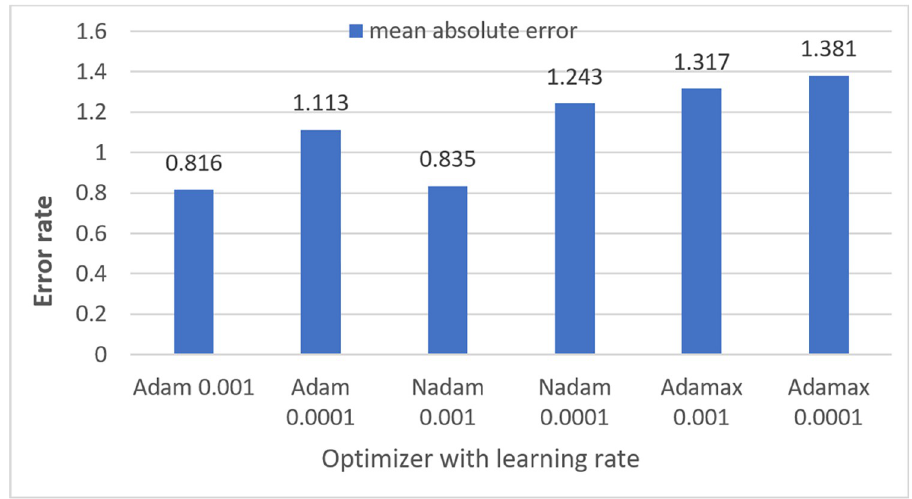
Fig 23. Mean absolute error of all six configurations of